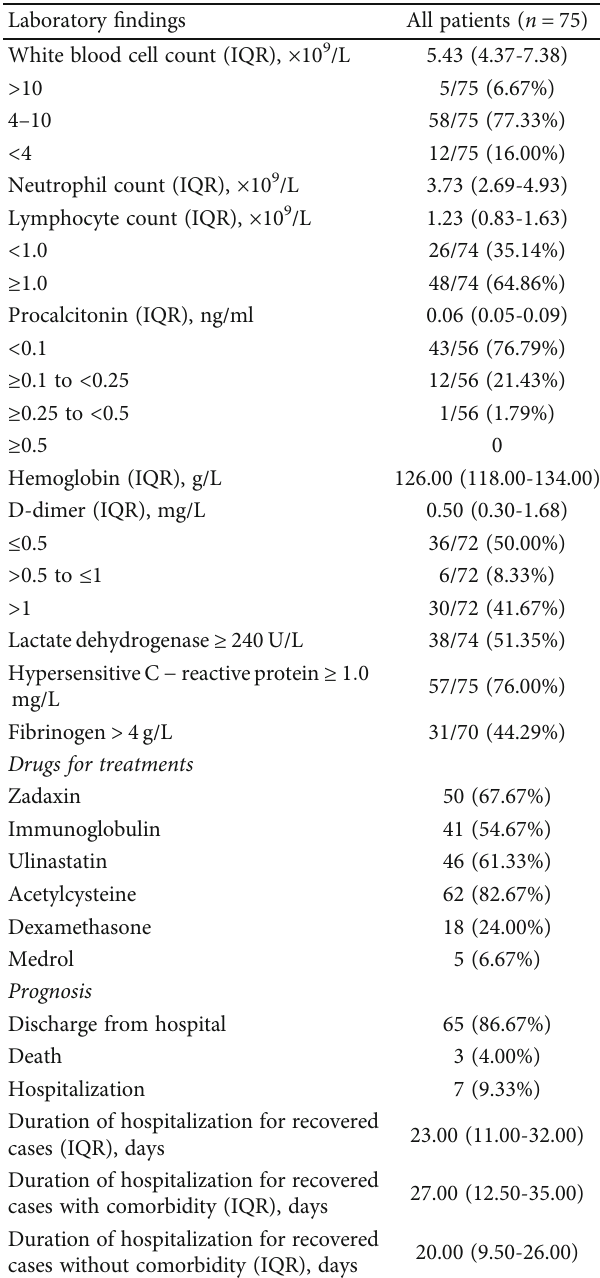
Table 2: Laboratory fi ndings at admission and treatment